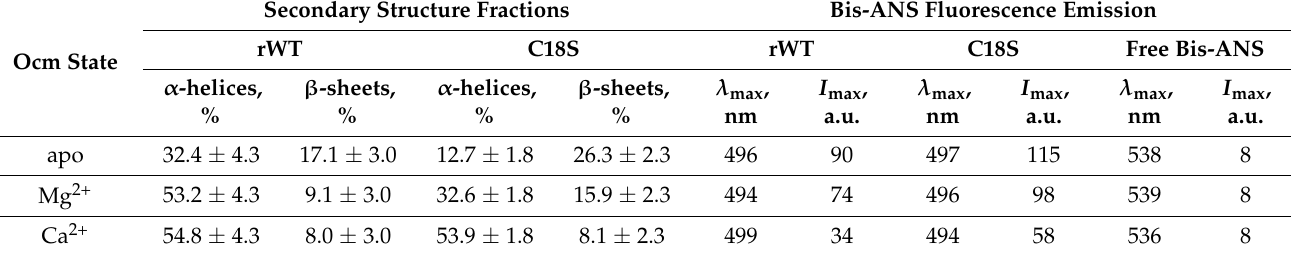
Table 1. The secondary structure fractions of rWT/C18S Ocm (7–13 µ M) estimated from far-UV CD spectra [45] and parameters of fluorescence emission spectrum ( λ max , spectrum maximum position; I max , maximum fluorescence intensity) of hydrophobic probe bis-ANS (1 µ M) in presence of the protein (18–23 µ M) at 20 ◦ C. Buffer conditions: 10 mM H 3 BO 3 -KOH, pH 8.8 or 10 mM Tris-HCl, pH 7.3 for CD studies; 10 mM HEPES-KOH, pH 7.3/8.2 for bis-ANS fluorescence measurements. Ca 2+ /Mg 2+ content was controlled by addition to the metal-depleted protein of 1.5 mM EDTA (apo-Ocm), 1 mM CaCl 2 (Ca 2+ -loaded Ocm) or 1 mM EGTA, 1 mM MgCl 2 (Mg 2+ -loaded Ocm). Standard deviations for estimates of the secondary structure fractions are indicated.